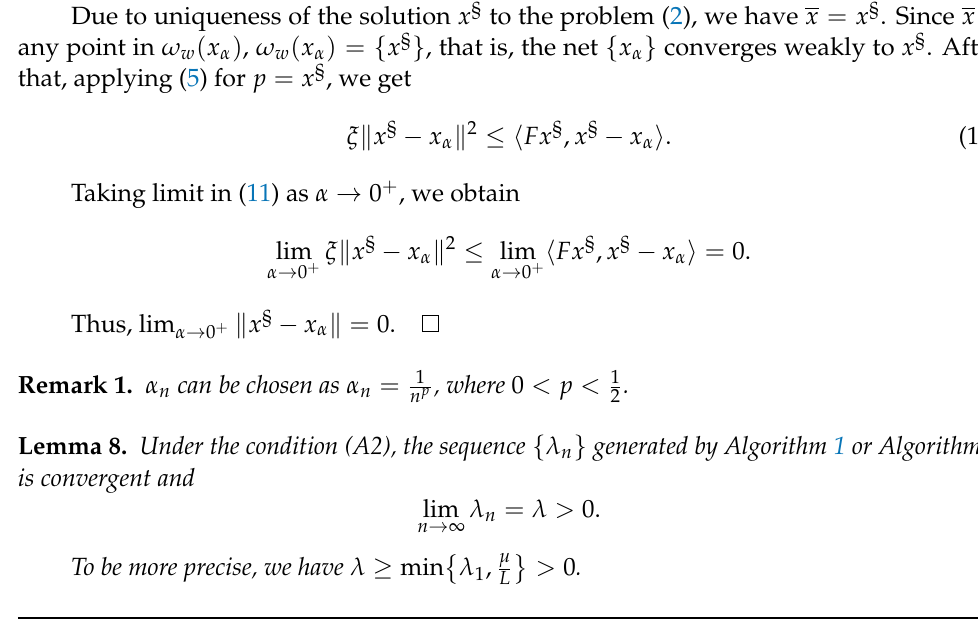
Algorithm 1 Modified multi-steps inertial forward-backward splitting method with regu-